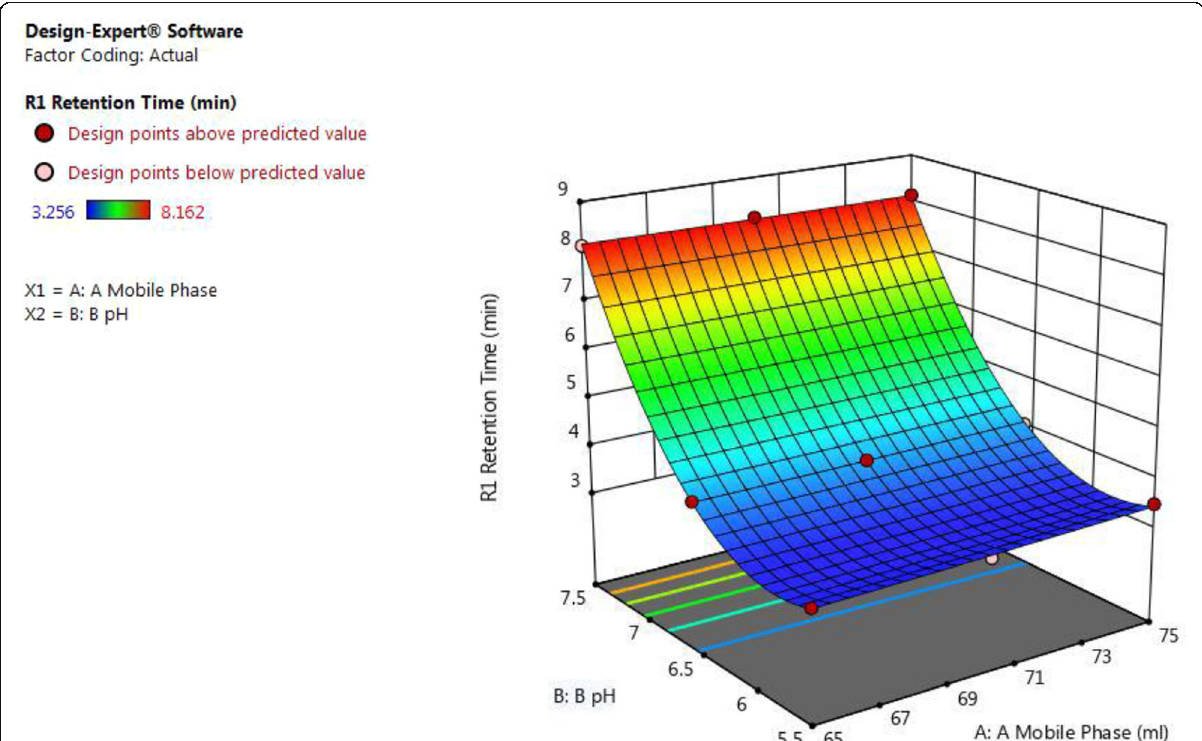
Fig. 1 3D surface plot for effect of combination of factors on R1 retention time of ceftriaxone sodium by using central composite